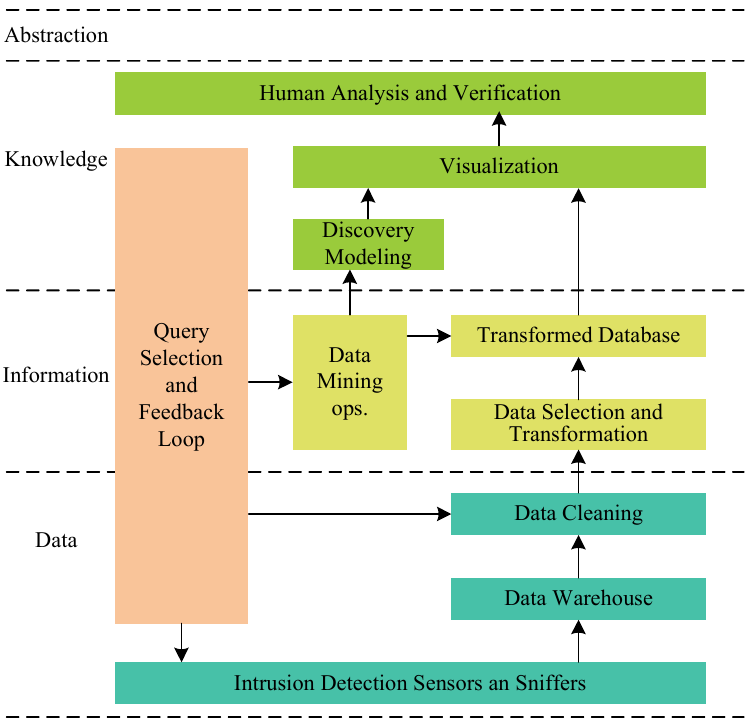
Figure 3. Intrusion detection data fusion model.